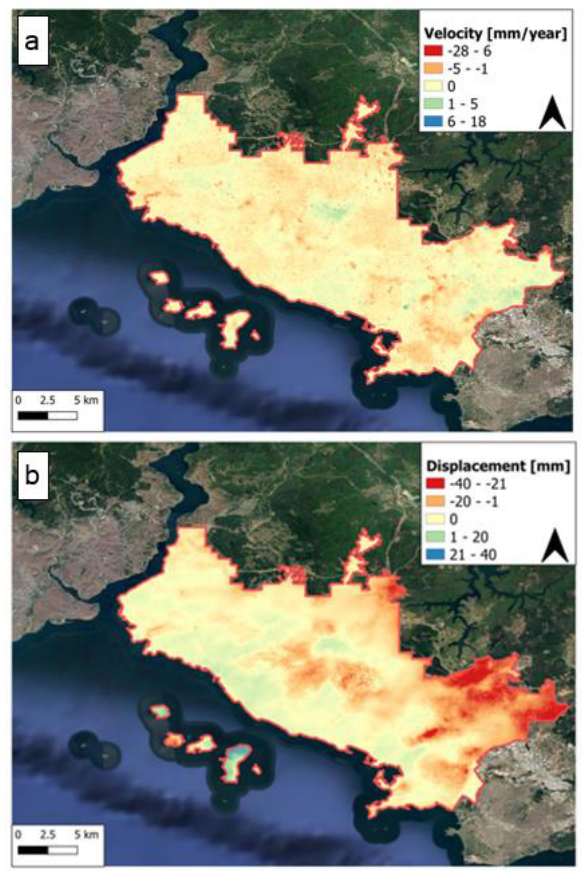
Figure 4. Amplitude of the annual displacement with a) PSI and b) LiCSBAS over the Google Earth satellite image. Note that colour scale is different between (a) and (b). For starting the gentrification, firstly the current status of urban sites which were determined as unsuitable or important area (A) should be examined. In the unsuitable sites, there are 12 urban areas, and 5 of them were found in danger based on both the PSI and the SBAS methods. As an example, Fig. 5 demonstrates the temporal trend of these measurements over one of the areas defined as in danger. PS points were shown over the Google Earth image in Fig. 5. Dots with different colours indicate the amplitude of the LOS movements. PS points with red colour, which had higher deformation velocity than the other measurement points, were selected to show the PSI time series, and the matched pixels with the red points were shown in the LiCSBAS time series. For the area, the LiCSBAS found lower deformation rate than PSI. Trendlines were given in the linear form. The LOS movement for this site reached nearly ~10 mm with LiCSBAS, ~70 mm with